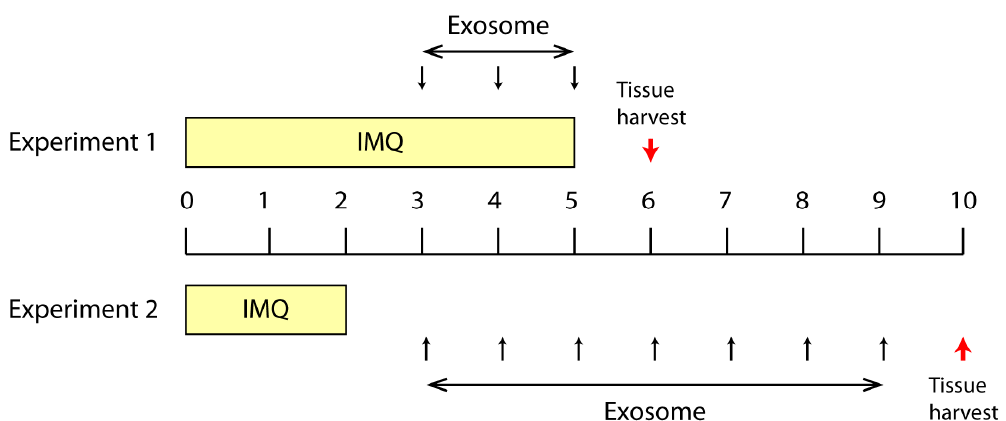
Figure 1. Summary of two treatment protocols in the Imiquimod (IMQ) induced psoriasis mouse model. In Expt.1, IMQ was topically applied from Day 0 to Day 5 and exosome cream was applied from Day 3 to Day 5. The experiment was terminated on day 6. In Expt. 2, IMQ was topically applied from Day 0 to Day 2 and exosome cream was applied from Day 3 to Day 9. The experiment was terminated on Day 10. The red arrow indicated the study termination day. This experiment was performed twice with two independently prepared batches of exosomes.